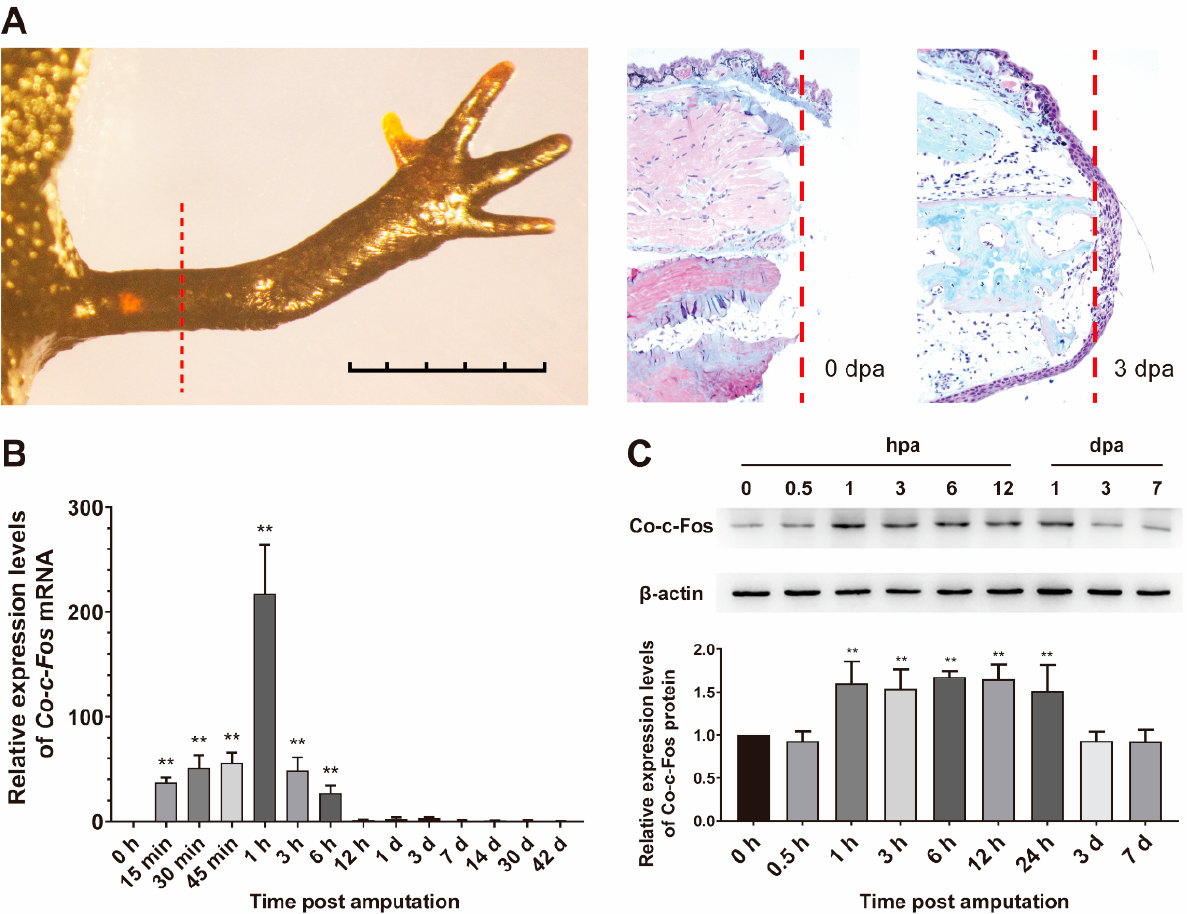
Figure 3. Expression pattern of Co-c-Fos gene during the newt limb regeneration. ( A ) The histological analysis of the limb regeneration with Masson’s trichrome at 0 and 3 days post-amputation. The red dashed line indicated the amputated position of the newt limb. ( B ) The mRNA expression pattern of Co-c-Fos during C. orientalis limb regeneration. The expression level of Co-c-Fos mRNA at 0 h was set to one ( n = 3). ( C ) Western blot analysis of Co-c-Fos protein at the early stage of C. orientalis limb regeneration. The abundance ratio to β -actin was analyzed by densitometry. Data were analyzed using one-way ANOVA with the least-significant difference test. ** p < 0.05.